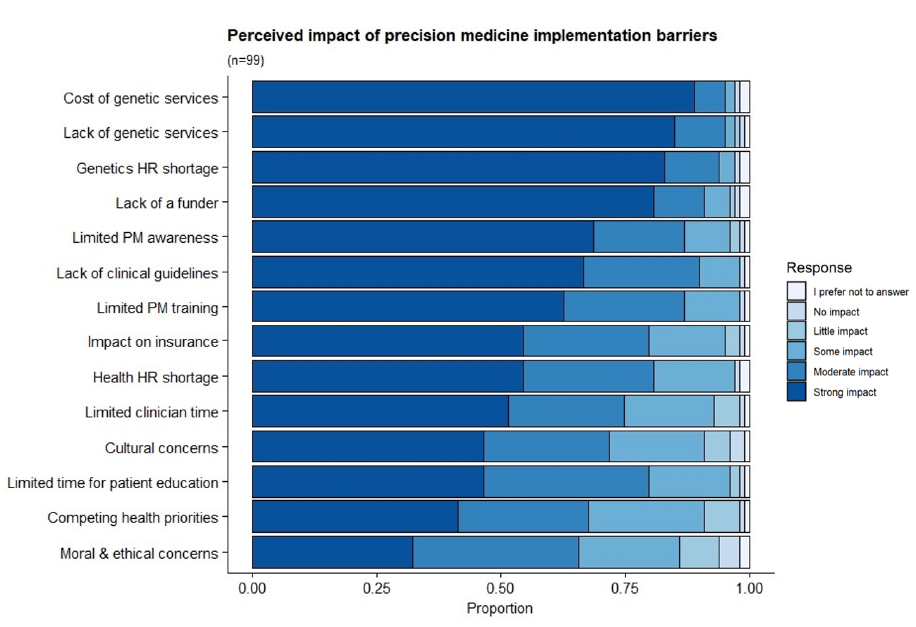
Figure 4. Perceived impact of PM-based CVD risk stratification implementation barriers in the South African public setting. The distribution of responses regarding the barriers facing the implementa- tion of PM-based CVD risk stratification in the South African public setting. of PM-based CVD risk stratification in the South African public